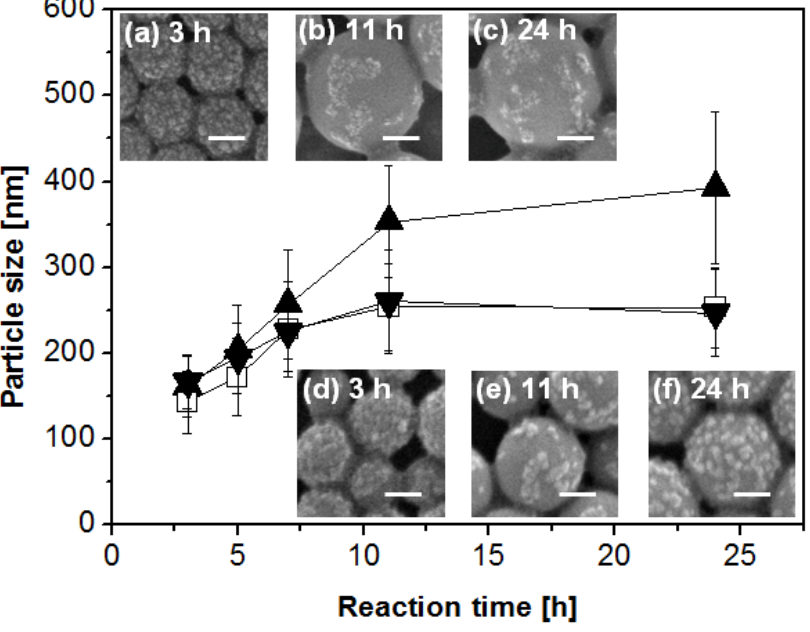
Figure 6. Plot of particle size versus reaction time and representative SEM images with different initiator VA-086 concentrations: 0.83 wt % ( ▲ , inset images a, b and c), 2.5 wt % ( □ ) and 4.2 wt % ( ▼ , inset images d, e and f). The error bars indicate the width of the particle size distribution and the scale bars represent 100